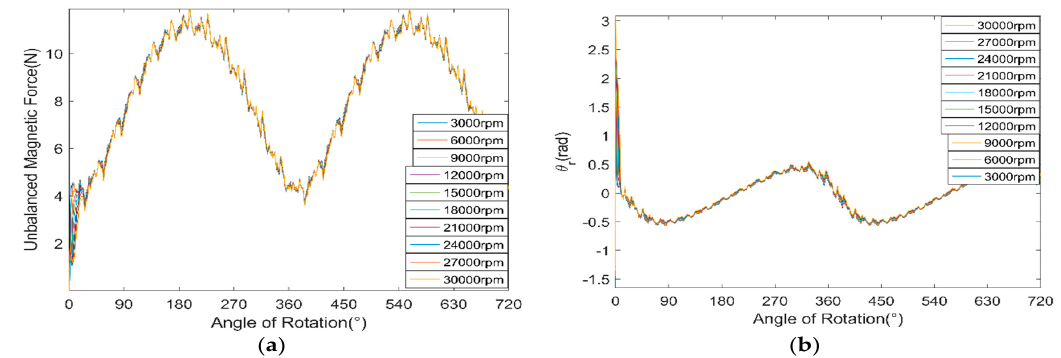
Figure 10. Variation of the UMF and its direction angle at different rotor speed. ( a ) UMF; ( b ) direction angle of the UMF.